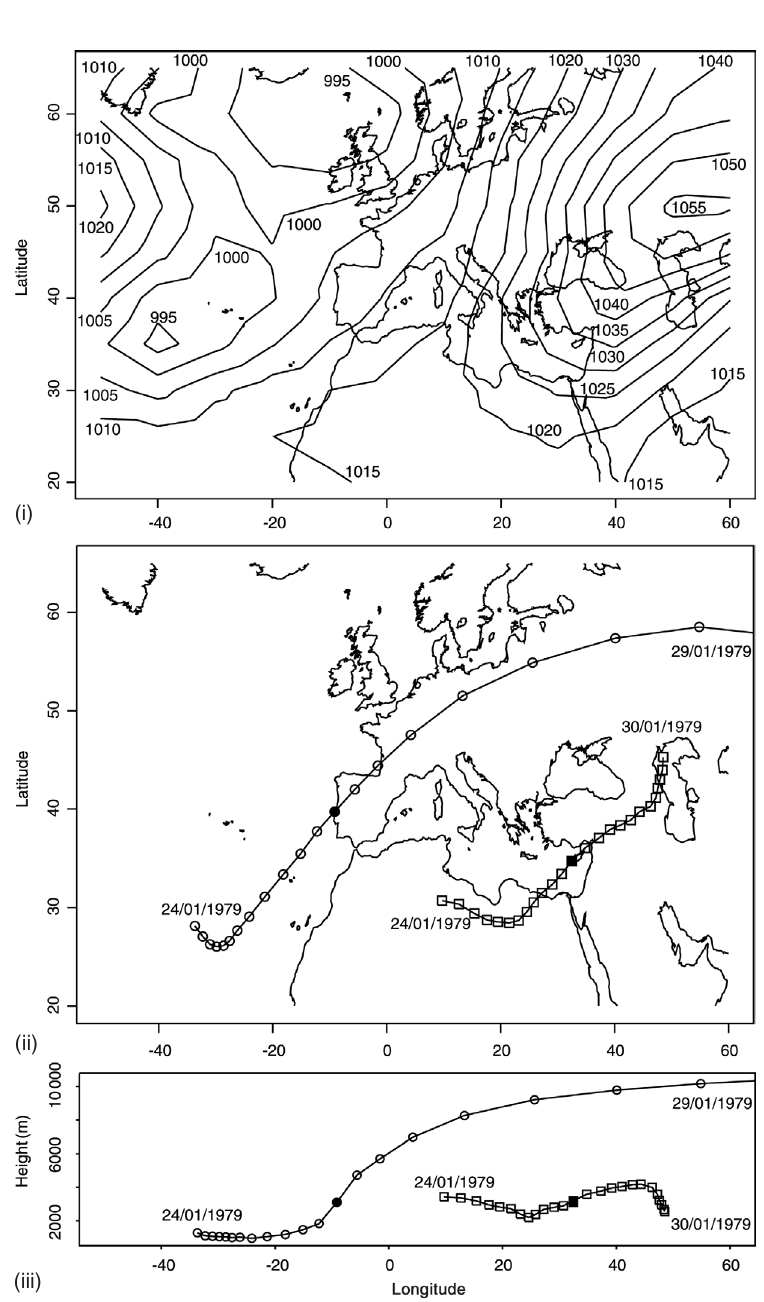
Fig. 6a. i) The pressure map for 26th January 1979. ii) The forward and back trajectories for the 700 mb level at Lisbon (crosses) and Paphos (open circles). The markers are placed at 6 hourly intervals. iii) The trajectory heights for Lisbon (crosses) and Paphos (open circles). Solid symbols 00:00 on